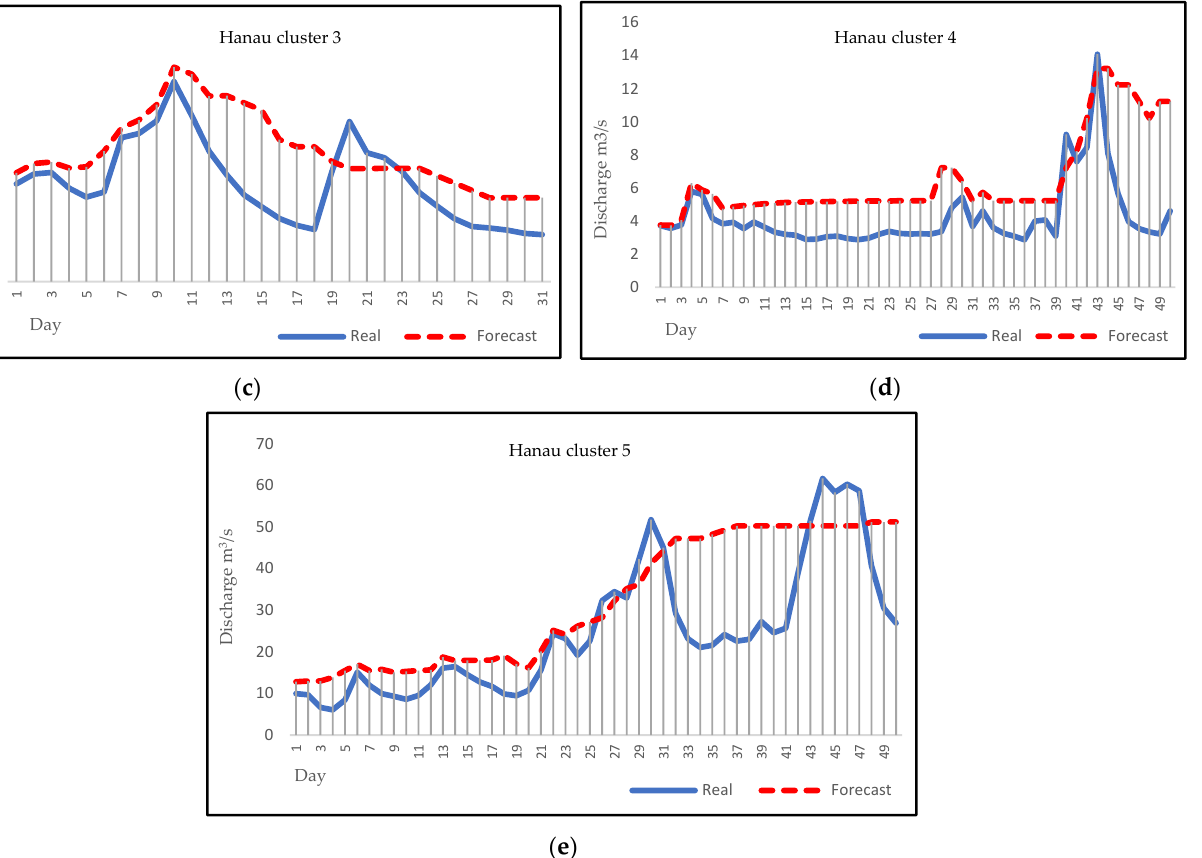
Figure 8. ( a ) Forecasting plot for Hanau cluster 1; ( b ) forecasting plot for Hanau cluster 2; ( c ) forecasting plot for Hanau cluster 3; ( d ) forecasting plot for Hanau cluster 4, ( e ) forecasting plot for Hanau cluster 5.